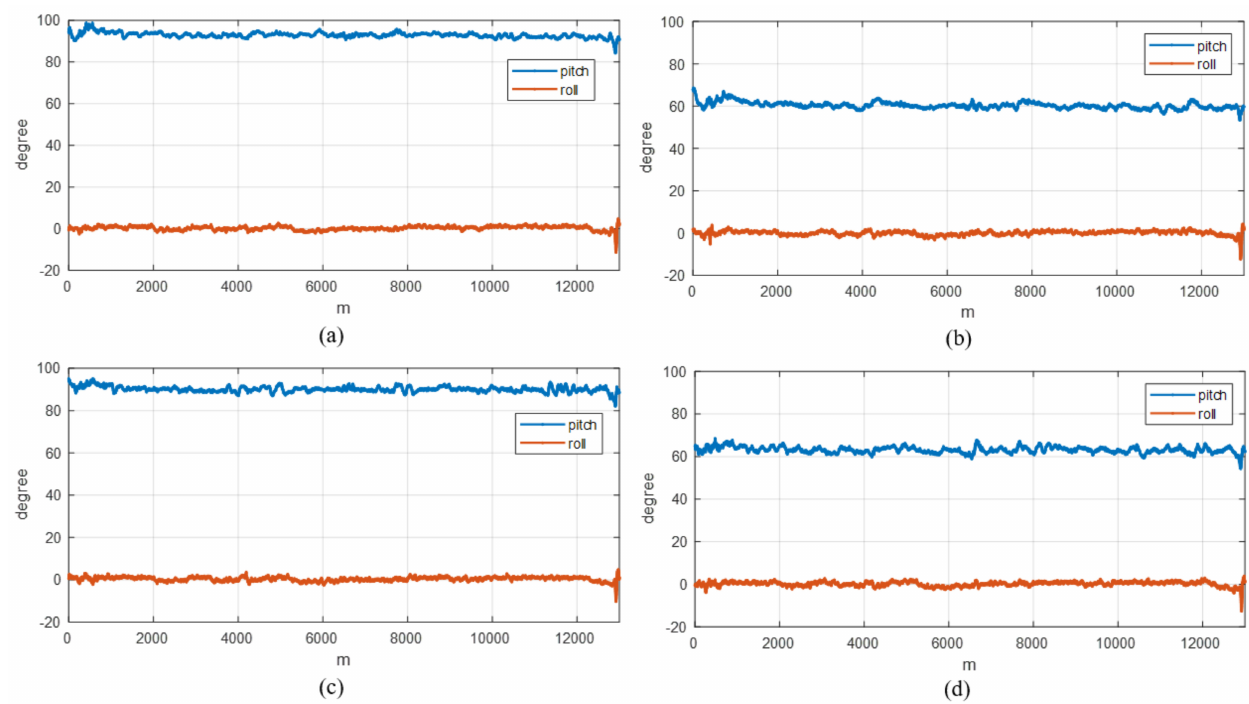
Figure 12. Attitude estimation results of all scenarios. ( a ) Scenario 1. ( b ) Scenario 2. ( c ) Scenario 3. ( d ) Scenario 4.